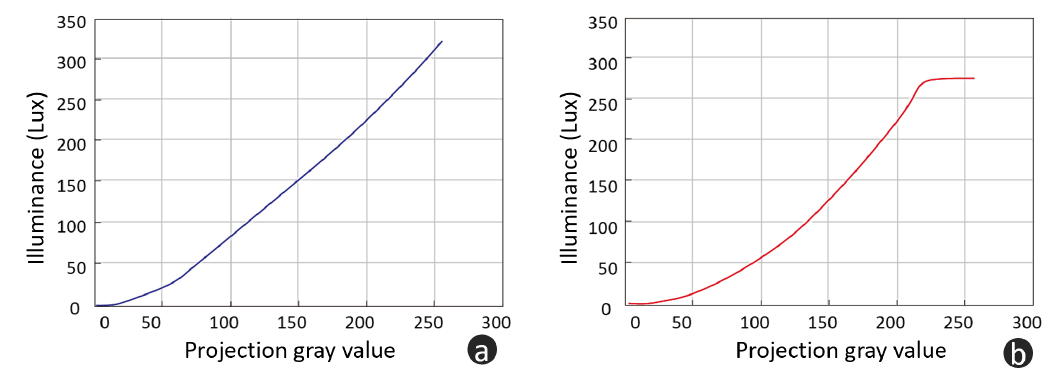
Figure 7. Linearity test. ( a ) proposed system; ( b ) commercial LED projector, item model: coolux